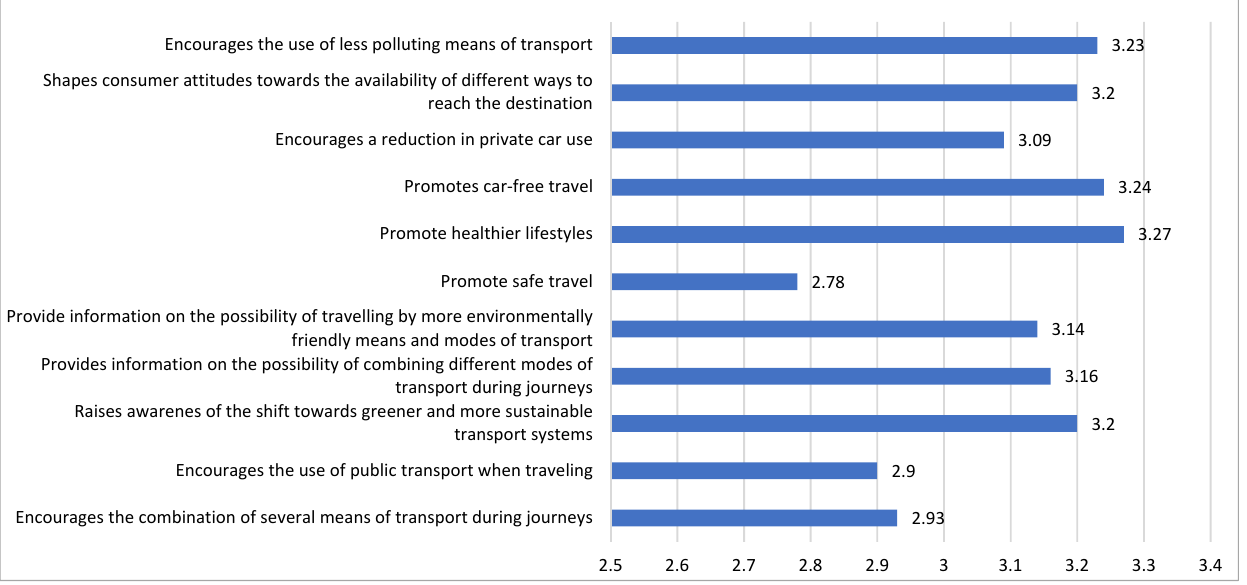
Figure 4. Evaluation of advertisements promoting sustainable mobility and multimodality ( n = 396; mean values ( M ), max = 5).